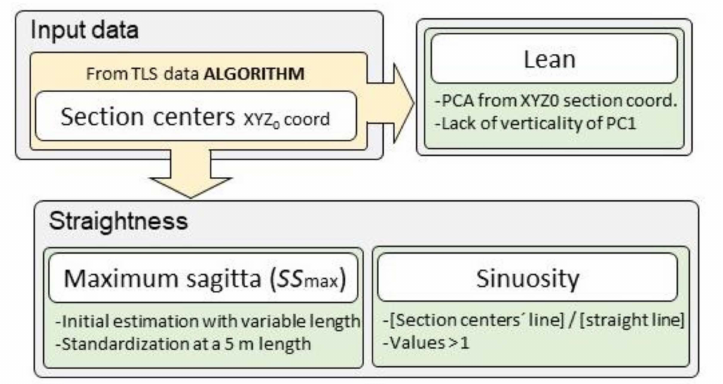
Figure 3. Workflow of the methodology for the automatic estimation of lean and straightness (maximum sagitta and sinuosity) from the coordinates of the section centers along the